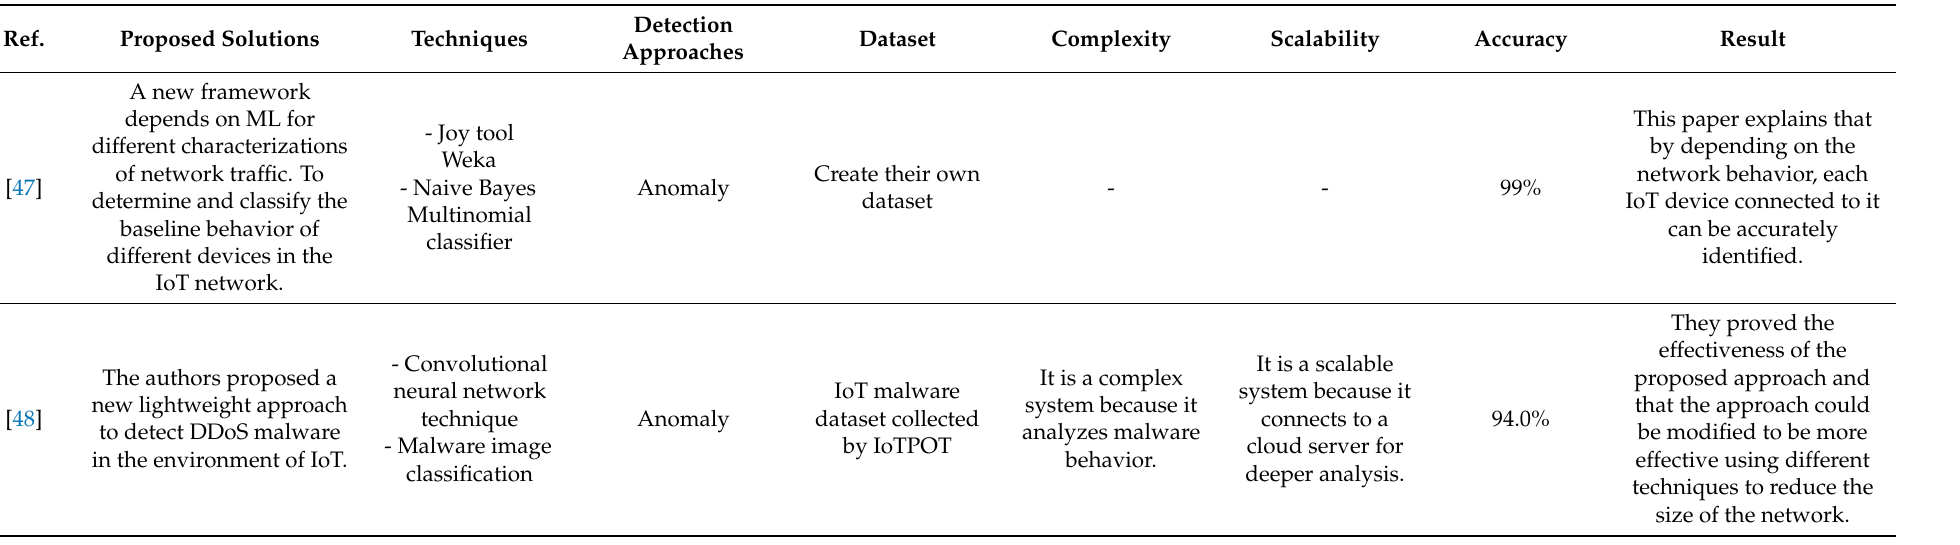
Table 3. ML-based security solutions in